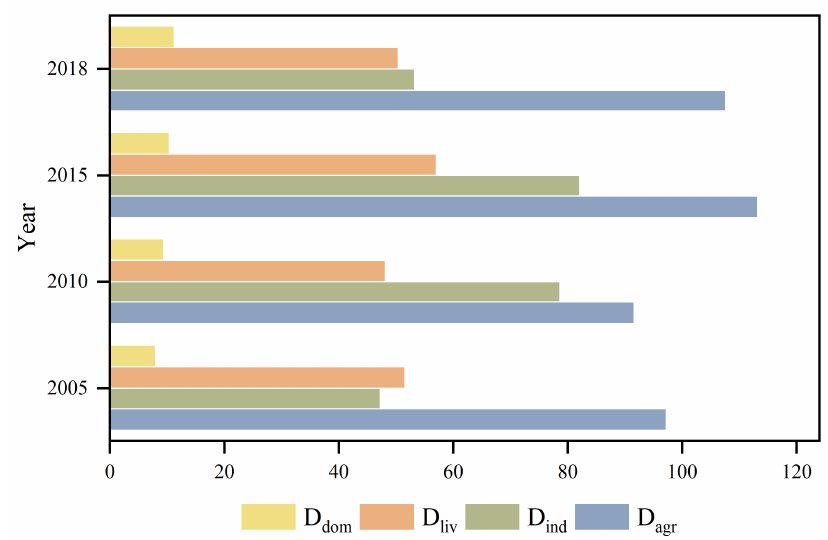
Figure 8. Water consumption by sector in the Three Gorges Reservoir Area from 2005 to 2018. D dom , D liv , D ind , and D agr represent the consumption of domestic water, livestock water, industrial water, and agricultural water ( × 10 8 m 3 ).